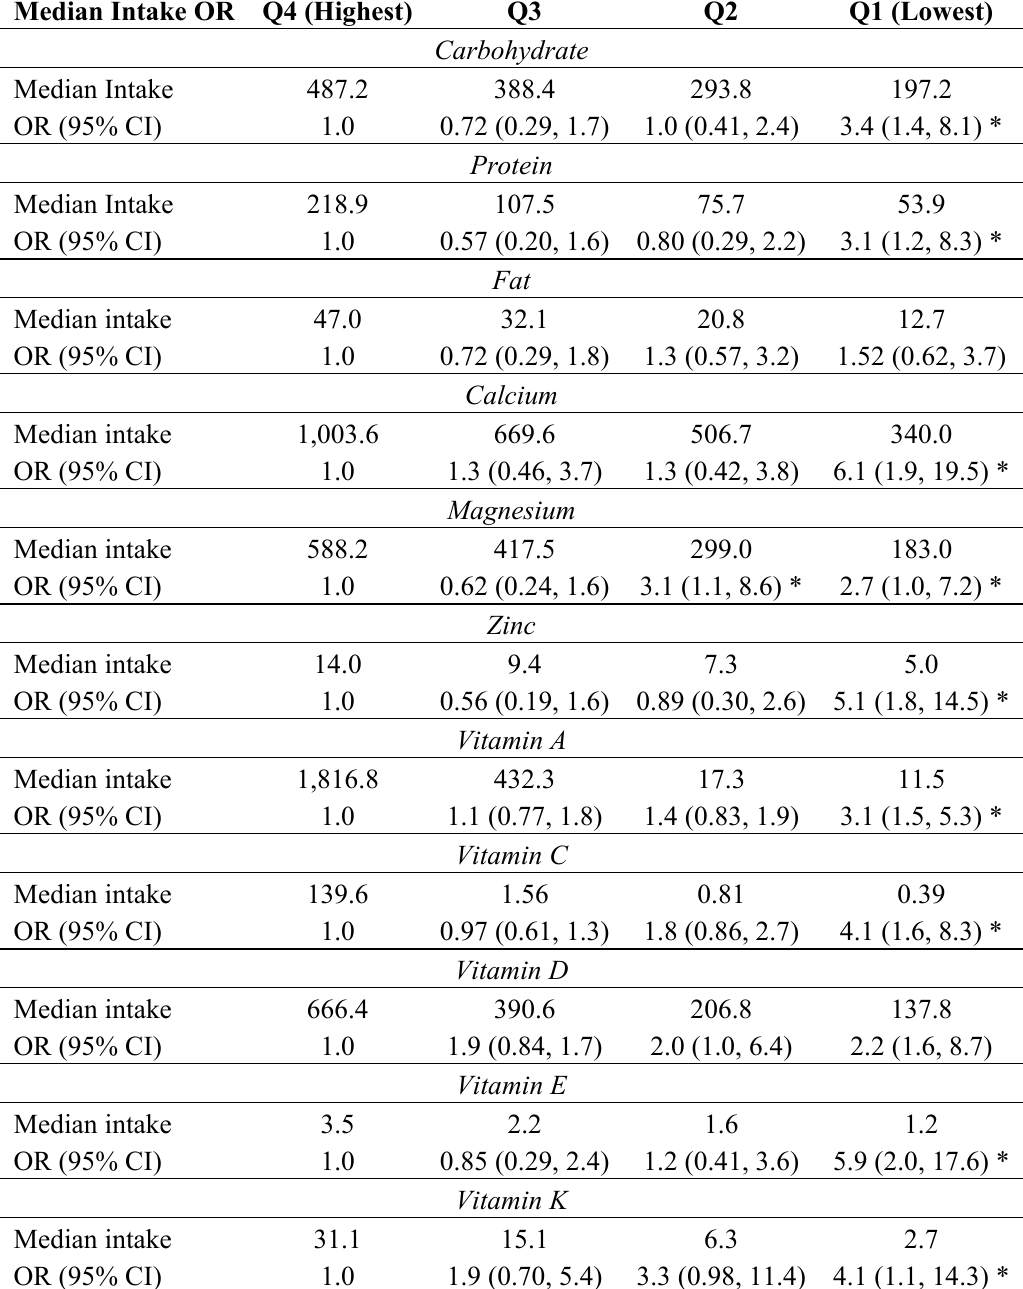
Table 4. Odd ratio (OR) (95% CI) of having metabolic syndrome by quartiles of dietary